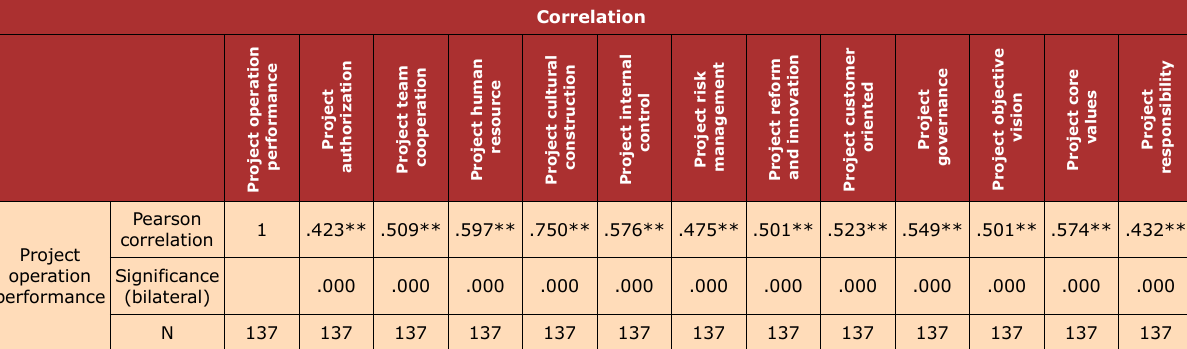
Table 9. Correlation analysis among the